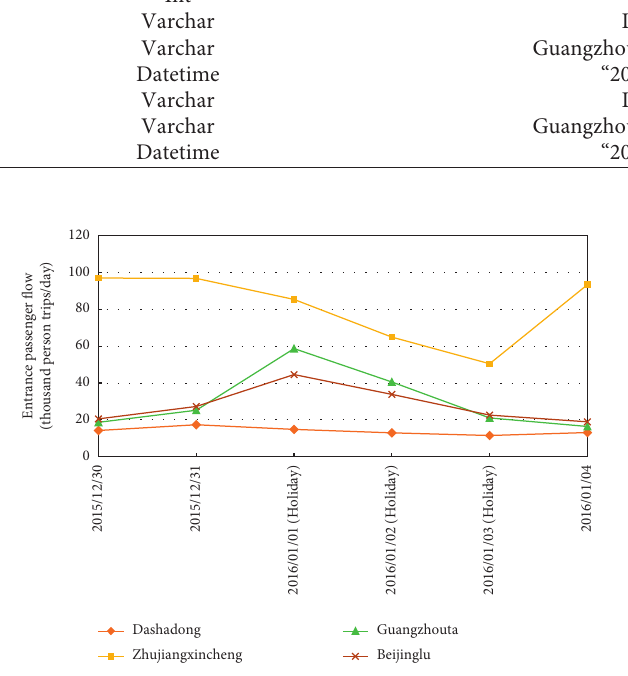
Figure 1: Entrance passenger flow of typical stations during New Year’s